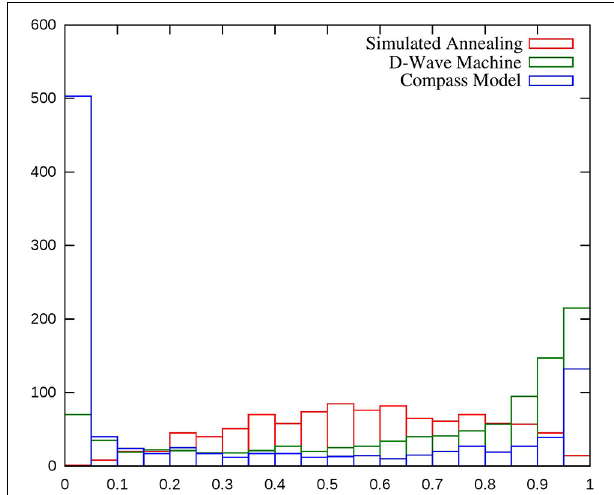
FIGURE 3 | Results of 1000 spin glass instances, each run 100 times on a noisy simulation of the classical compass model with T = 1000. A bimodal distribution is observed, with a clear separation between easy and hard instancesd with high and low success probabilities respectively. The noise applied was random kicks to each ˙ θ at t = 10 , 20 ,..., 1000 uniformly chosen between ± 0 . 0015. The results are compared to the experimental data of Boixo et al. [2] and to an illustrative run of simulated